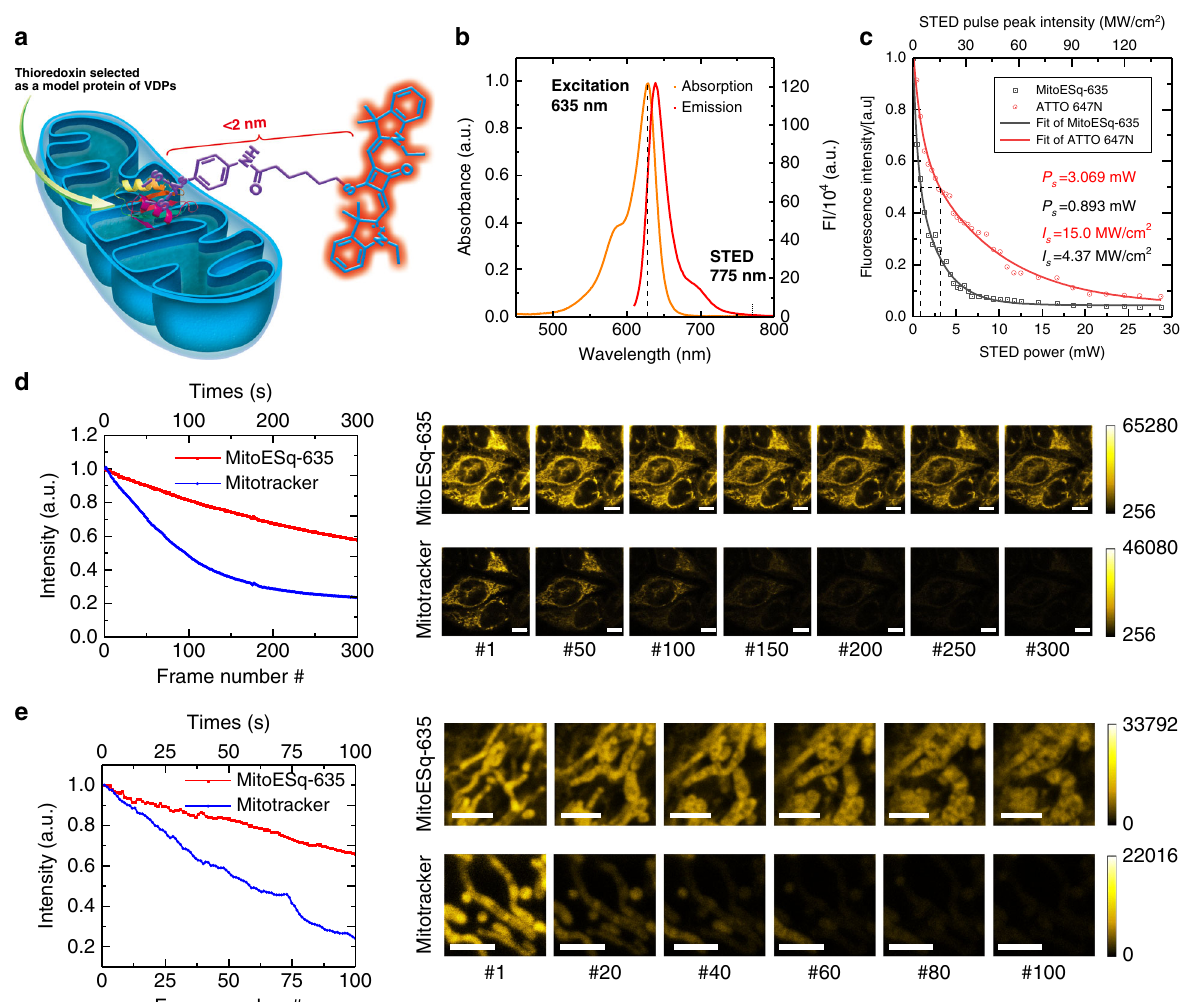
Fig. 1 A highly photostable, bright, enhanced squaraine probe for mitochondria labelling. a Chemical structure of MitoESq-635 used for the speci fi c labelling of VDPs. b Absorption and emission spectrum of the enhanced squaraine dye, for which a 775-nm pulse laser can be employed for depletion and a 635-nm can be employed laser for excitation during the STED setup. c The detected fl uorescence signal of the MitoESq-635 and ATTO 647N solution dye pool on a coverslip as a function of the depletion beam intensity; the excitation beam was 635 nm with a 5-ps pulse width and 80 MHz, and the STED beam was 775 nm with 600 ps pulse width and 80MHz. d Comparison of photostability under a confocal laser microscope of HeLa cells co-stained with MitoESq- 635 (0.1 μ M) and MitoTracker Green (Rhodamine123) (0.1 μ M). Upper row, MitoESq-635 excited at 633nm and collected at 645 – 680 nm. Lower row, MitoTracker Green (Rhodamine 123) excited at 488 nm and collected at 500 – 560nm. Confocal images were obtained under the same imaging conditions, excitation under 1.97 μ W averaged power and 1 frame per s acquisition speed (imaging time: 0.66 s, recovery time: 0.34 s). The fl uorescence signal of each image is plotted as a function of the recorded image number. Scale bar, 10 μ m. e Comparison of the photostability under a STED nanoscope of living HeLa cells stained with MitoESq-635 (0.1 μ M) and MitoTracker DeepRed (0.1 μ M). STED images were obtained under the same imaging conditions: excitation under 1.1 µ W averaged power at 640 nm, STED beam of 30.2 mW average power at 775 nm, and 1 frame per s acquisition speed (imaging time: 0.66s, recovery time: 0.34s). The fl uorescence signal of each image is plotted as a function of the recorded image number. Scale bar, 2.5 μ